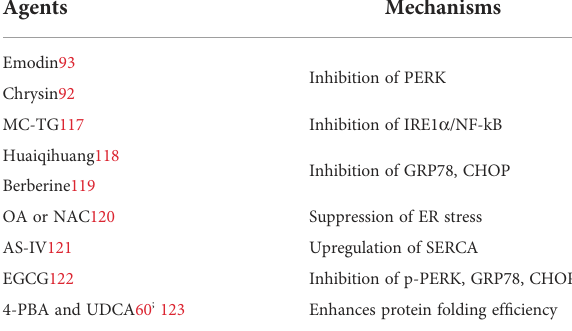
TABLE 2 Therapies targeting ER